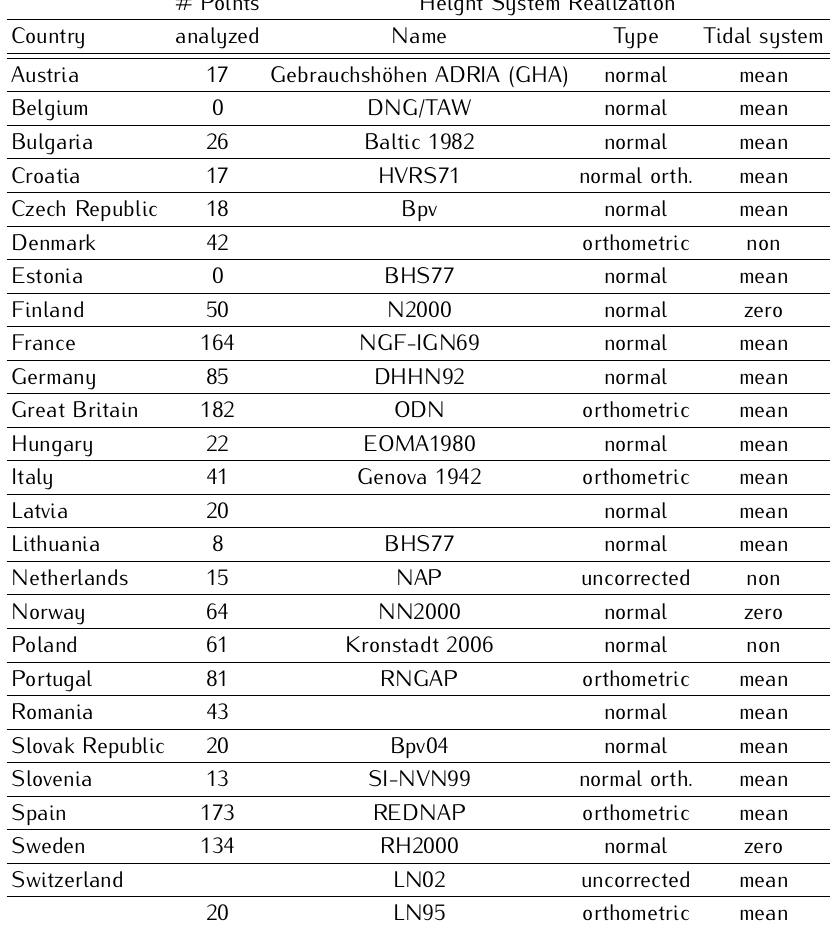
Table 1. GNSS/Leveling points of the EUVN_DA data set in Europe. Height system realization and tidal system of the national physical heights.